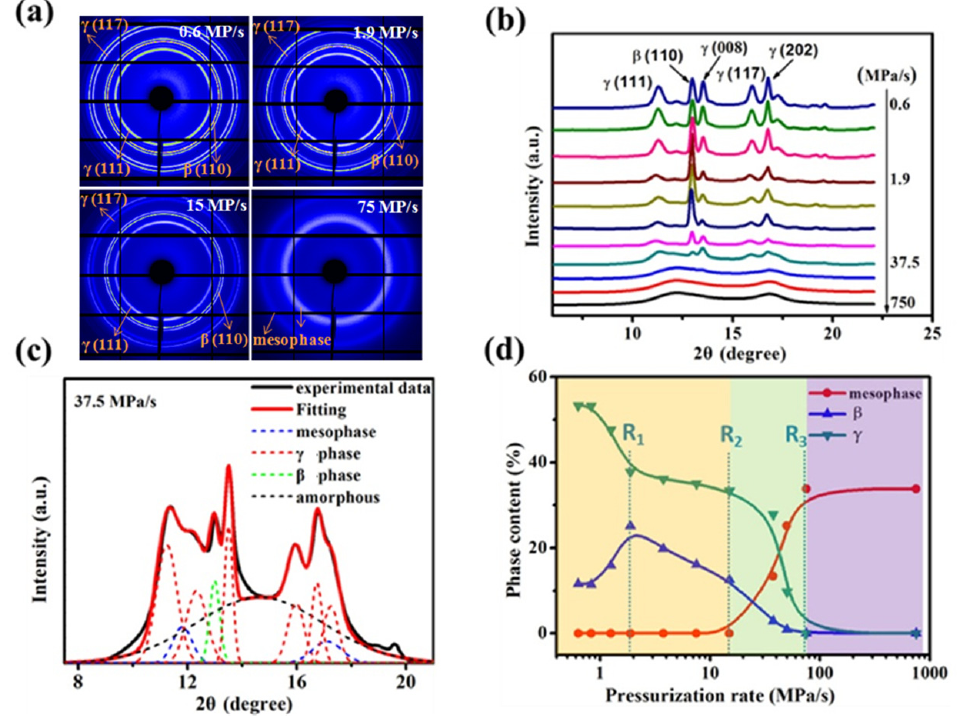
Figure 3. ( a ) Selected 2D WAXD patterns and ( b ) 1D WAXD profiles of iPP0.2 samples solidified by pressuring to 1.7 GPa at different pressurization rates; ( c ) the fitting curves of WAXD of amorphous, mesomorphic, β - and γ -phases; ( d ) fractions of different phases as a function of pressurization rates. To quantify the changes in crystallization polymorphism, the 1D WAXD signals were decomposed into specific contributions from γ -, β -, mesomorphic, and amorphous phases, see the representative fitting in Figure 3c [36], which displays a representative fitting performed on the WAXD profiles. Figure 3d presents the changes of the phase contents as a function of pressurization rate, and three critical rates (indicated by dotted lines) were identified. For simplified analysis, the amorphous phase is not taken into consideration. It can be seen that, at the lowest pressurization rate of 0.6 MPa/s, only β - and γ -iPP were obtained with the fractions of 11% and 54%, respectively. When the pressurization rate increases to 1.9 MPa/s (denoted as R 1 ), it causes an obvious decrease in γ -iPP crystallinity from 54% to 40%, but the crystallinity of β -iPP increases visibly from 11% to the maximum point of about 24%. The increase in β -iPP crystallinity is almost equal to the decrease in γ -iPP crystallinity, meaning that the content of β -iPP increases at cost of the γ -iPP [25,37]. Once that rate exceeds R 1 , β -iPP and γ -iPP crystallinities both decrease gradually. When that rate further exceeds 15 MPa/s (denoted as R 2 ), the mesophase begins to emerge, and mesomorphic, β -, and γ -iPP coexist with each other. After reaching 75 MPa/s (denoted as R 3 ), pure mesophase could be obtained and its fraction content reaches the maximum of about 32%. It is worth noting that with pressurization, the formation of metastable structures has been observed for different kinds of polymers, and for iPP pressurization can induce more effects than temperature cooling on the formation of mesophase